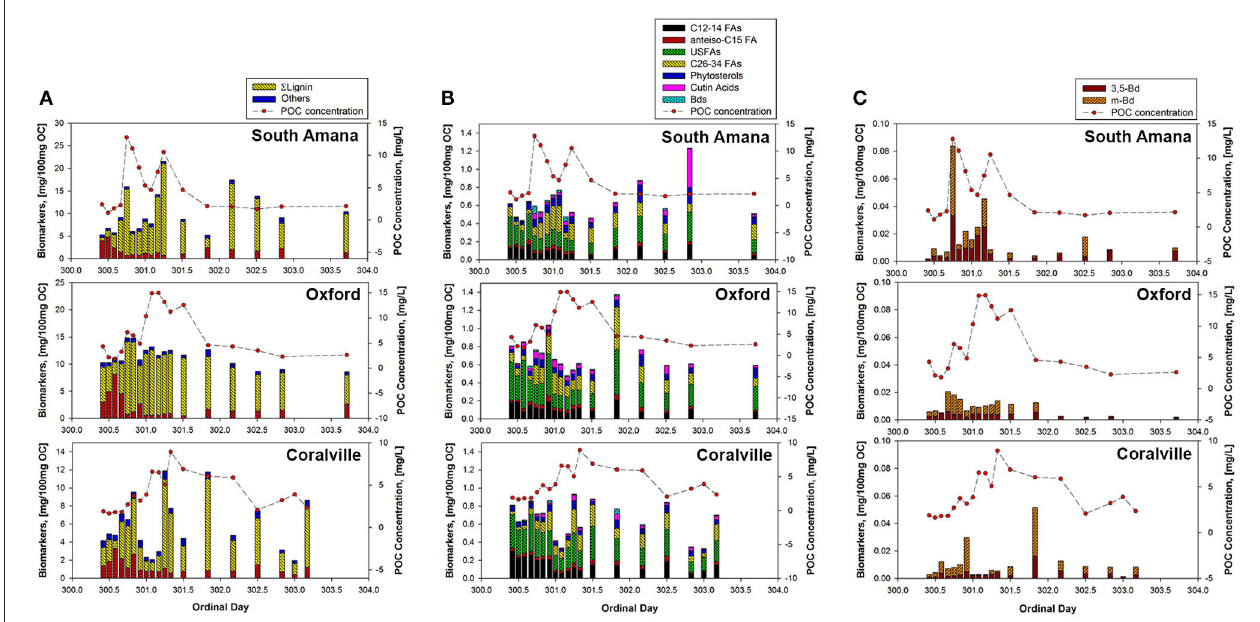
FIGURE 4 | Concentrations of biomarkers normalized to OC (mg/100mg OC). (A) All biomarkers measured using TMAH thermochemolysis; (B) Biomarkers excluding C16-18 fatty acids and lignin phenols; (C) Concentrations of Bds. 6 Lignin, Total lignin phenols; anteiso-C15 FA, anteiso-pentadecanoic acid; USFAs, unsaturated fatty acids (C16:1 FAs, C18:1 FAs, and C18:2 FA); Cutin acids, 9,16-dihydroxyhexadecanoic acid, 10,16-dihydroxyhexadecanoic acid, and 9,10,16-trihydroxyoctadecanoic acid; Bds, m-hydroxybenzoic acid and 3,5-dihydroxybenzoic acid; PSs, phytosterols (stigmasterol and β